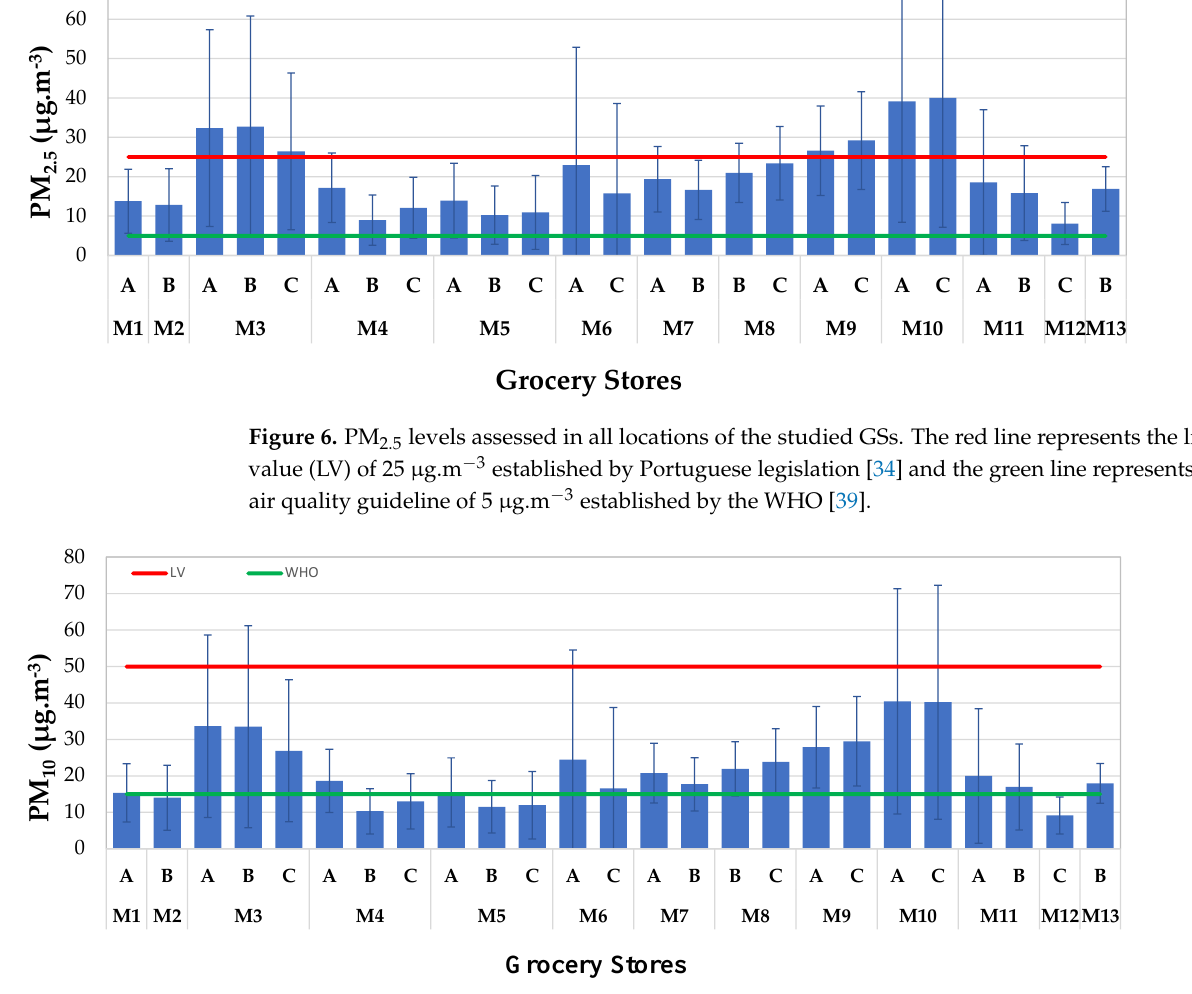
Figure 7. PM 10 levels assessed in all locations of the studied GSs. The red line represents the limit value (LV) of 50 µg.m −3 established by Portuguese legislation [34] and the green line represents the air quality guideline of 15 µg.m −3 established by the WHO [39]. Similar results were found in a study in classrooms in France, with mean PM 2.5 levels of 22 ± 8 μg.m −3 , ranging from 10 to 47 μg.m −3 [40]. In contrast, less-crowded environments have a lower possibility of resuspension of particles. Therefore, for example, a study in elderly care centers in Lisbon assessed lower PM 10 levels, ranging from 11 μg.m −3 to 19 μg.m −3 [33]. In relation to the influence of other GS characteristics, no other significant impacts were found on either PM2.5 or PM10. However, some studies showed that some activities in houses had peak concentrations of PM, such as during the preparation of breakfast, tea, and toast, and natural-gas burning, as well as other types of cooking [41 – 43]. Some retail environments have different indoor spaces within and with different associated activities, which can promote different emissions of pollutants (including particulate matter, from fine to ultrafine particles) [44]. This is the case for some of the studied GSs, which have different areas within, such as a bakery or coffee shop, that may promote higher levels of PM when compared with GSs without those types of facilities.